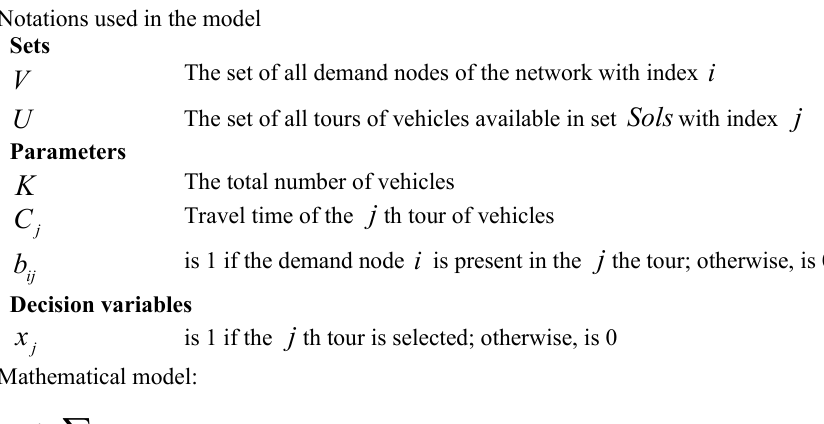
Notations used in the